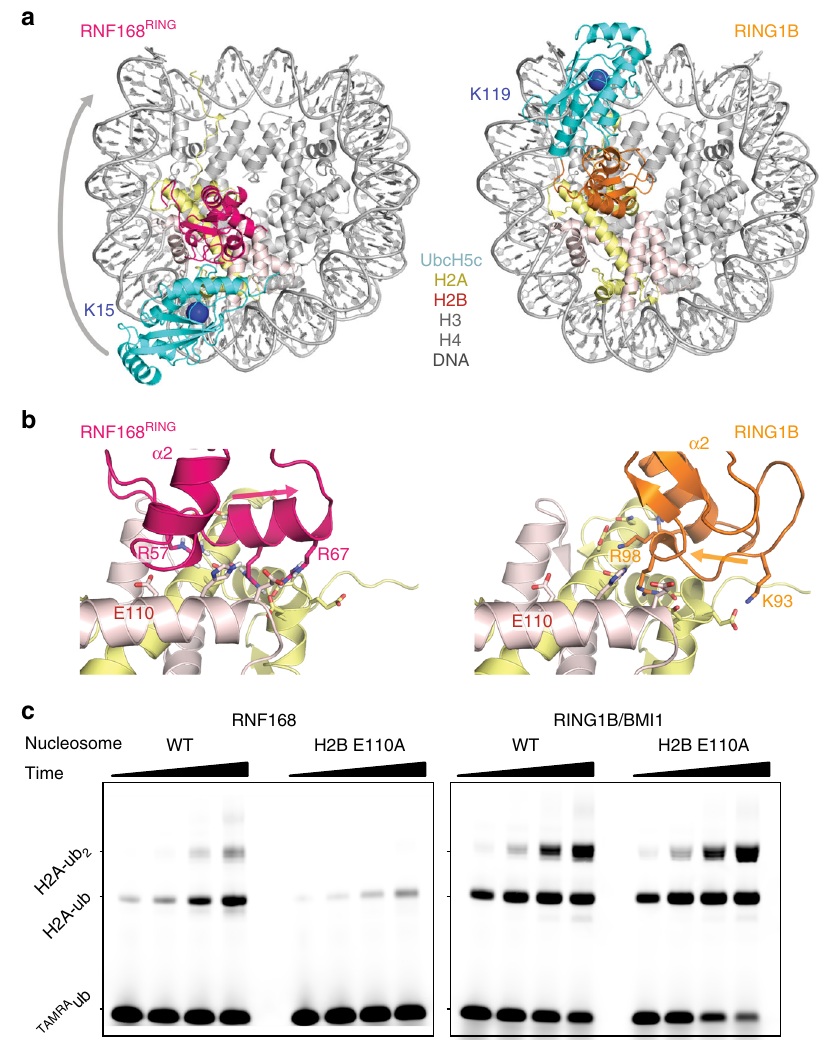
Fig. 4 Uncoupling of PRC1 and RNF168 ubiquitination. a Top view on the nucleosome highlighting the 180° rotated position of UbcH5c in the RNF168 (left) compared to RING1B nucleosome complex (right). Color coding indicated in the Figure, position of the target lysines is indicated with the blue sphere. b Side-by-side comparison of the RING domain positions on the acidic patch, RNF168 (right) and RING1B (left). Secondary structure elements are labeled to highlight the approximate 180° turn of the RING domain, also indicated by the arrow. The H2B E110 (E113 in humans) side chain is close to the E3 RING surface for RNF168 but far from the surface of RING1B. Selected side chains are shown as sticks. c Nucleosome ubiquitination by either RNF168 RING or RING1B/BMI1 on wild-type (WT) or H2B E110A nucleosomes. Fluorescent TAMRA-labeled ubiquitin was used to detect ubiquitinated species. Samples were resolved using SDS-PAGE. For all samples time points were taken at 2, 6, 18, and 40 min of incubation of the reaction mixture. Molecular size of mono- and di-ubiquitinated H2A is indicated. Source data are provided as a Source Data fi